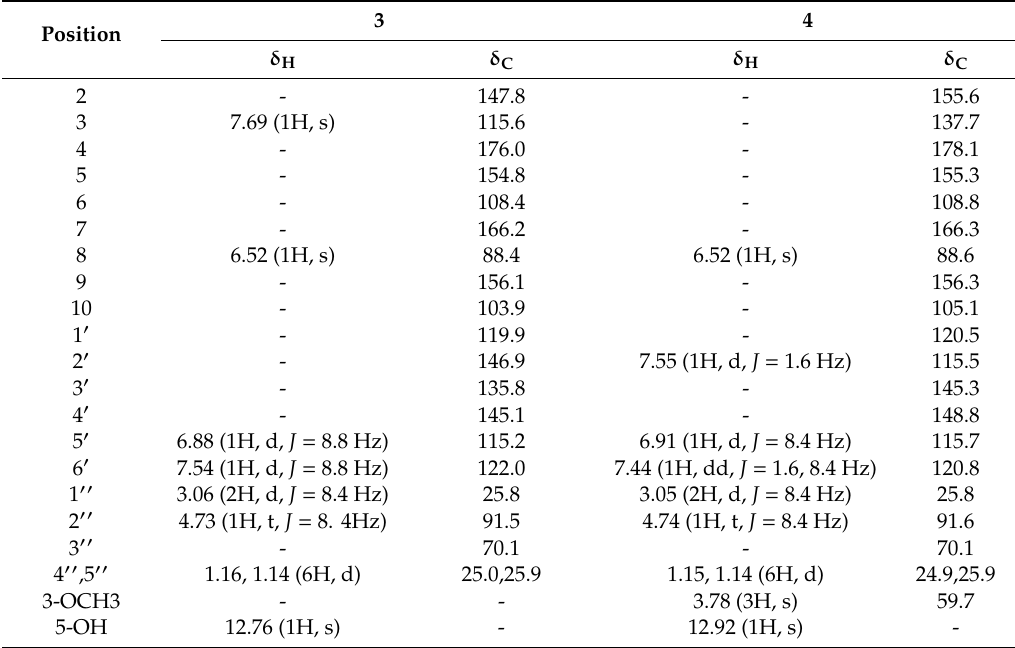
Table 2. 1 H- and 13 C-NMR spectroscopic data of compounds 3 – 4 (400 MHz for 1 H-NMR and 100 MHz for 13 C-NMR, in DMSO- d 6 , δ in ppm, J in Hz)